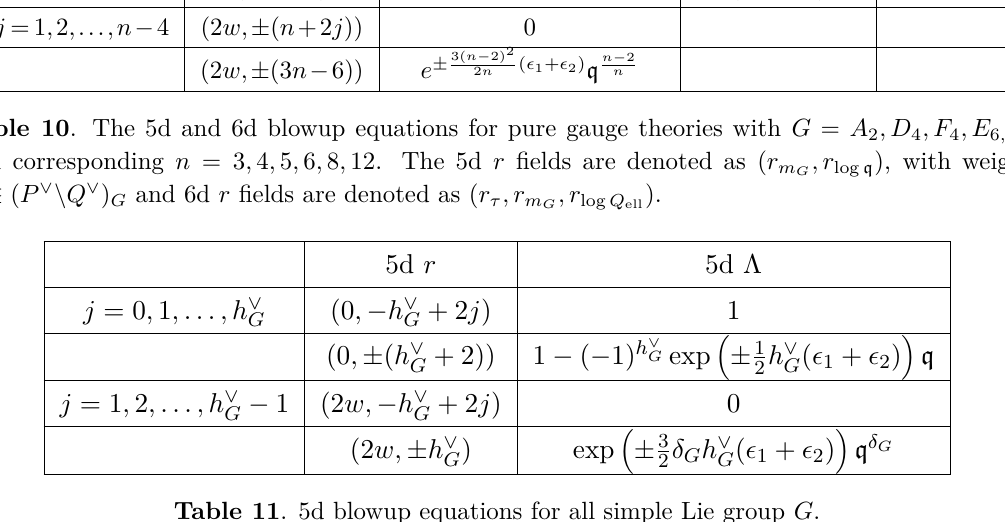
Table 11 . 5d blowup equations for all simple Lie group G